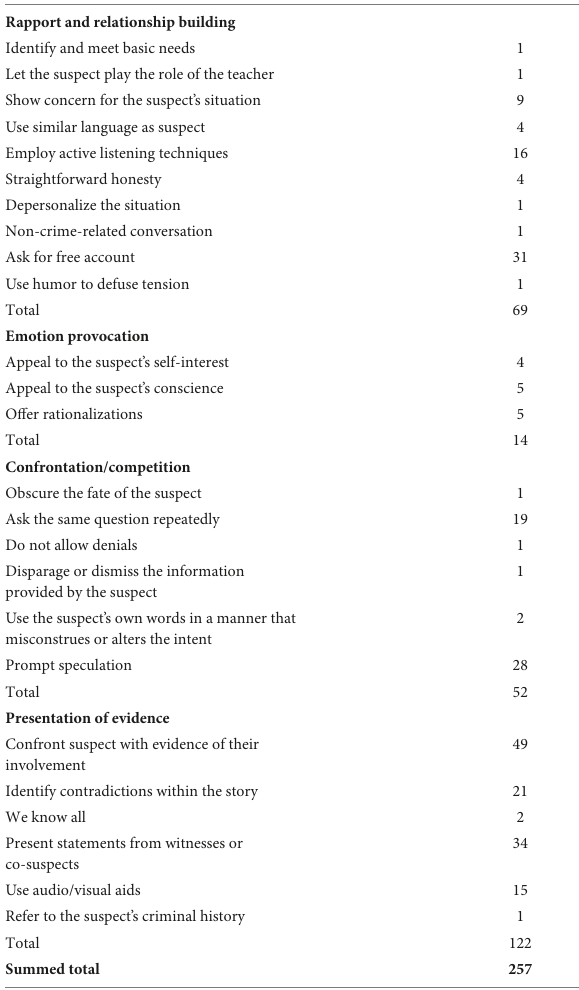
TABLE 4 Descriptive information for question categories, specific question types, AQD and domains in Study 2 ( N = 97).